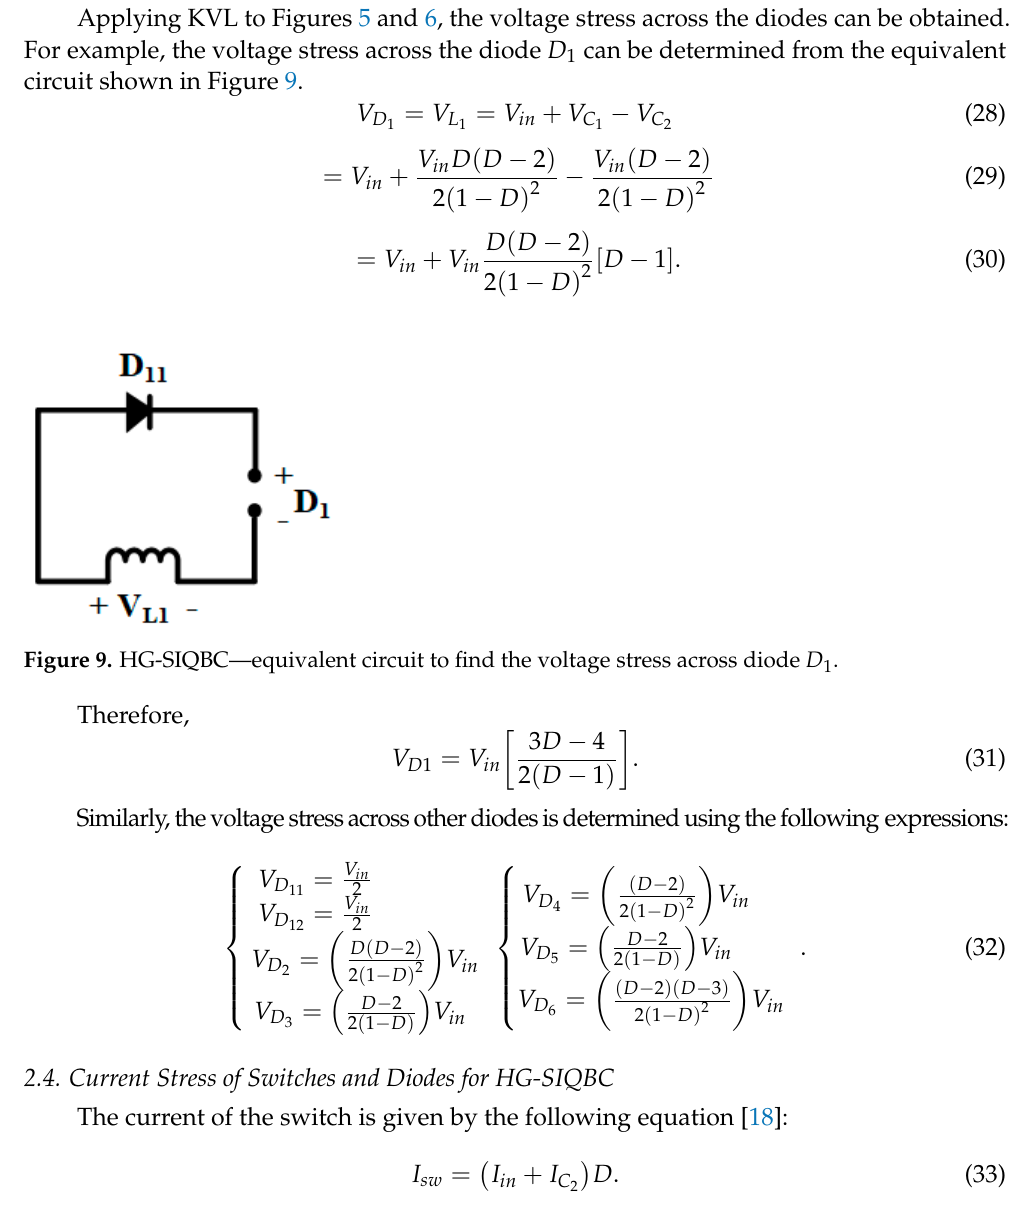
Figure 8. HG-SIQBC—equivalent circuit to find the voltage stress across the switch . (The current flow is given in dotted lines).